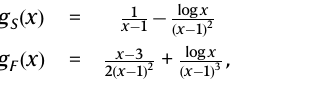
Fig.3|Scalarleptoquarkexplanation. Regionsinthe Δ m (cid:1) model that predict the W -boson mass and muon g − 2 in agreement with mea- surements.The mixingangle ϕ issettobe − π /8and m S is excluded by the perturbativity requirement ∣ λ ∣ <